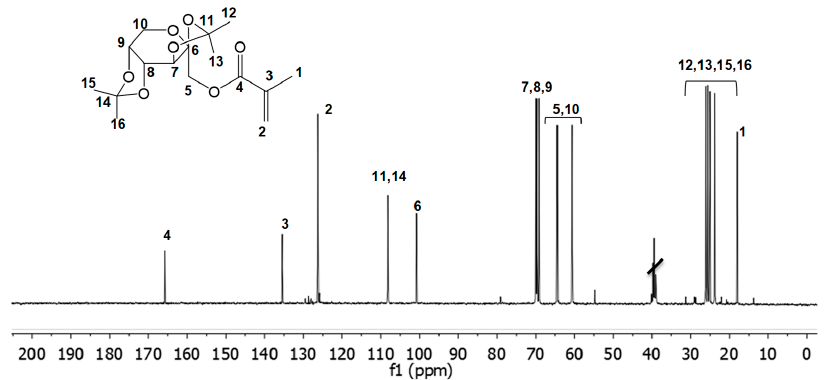
Figure 2. 13 C-NMR spectrum of the methacrylate protected fructose (MF) monomer in DMSO- d 6 .